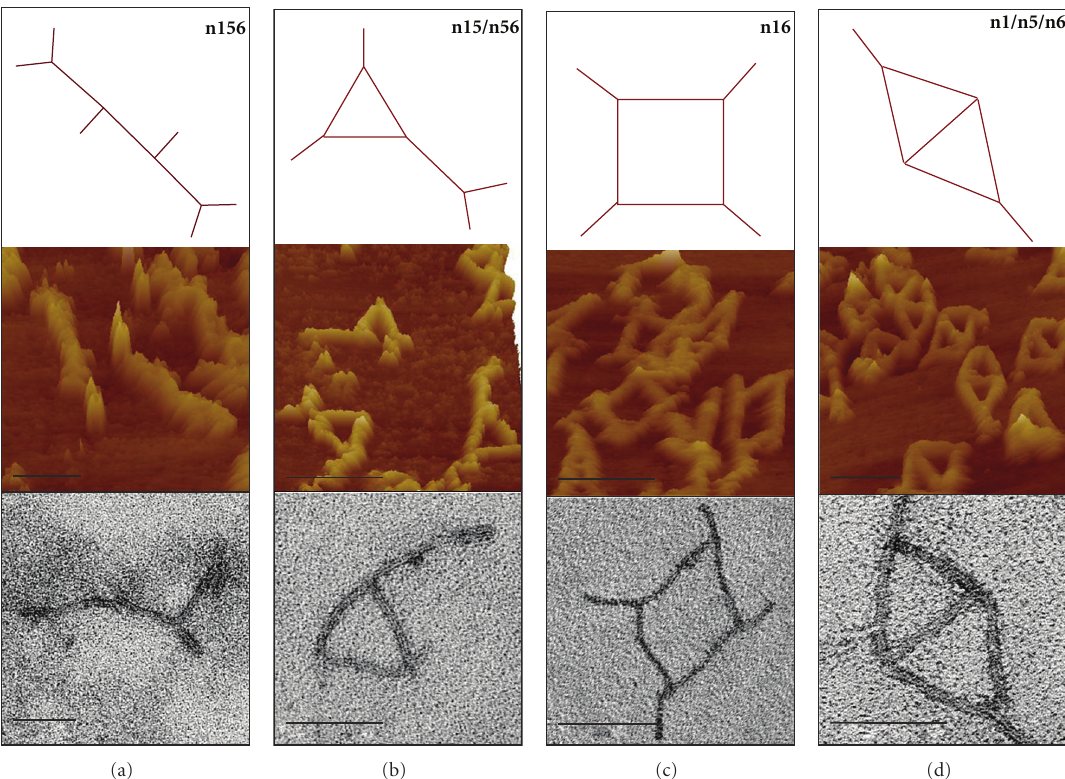
Figure 3: Schematic (upper row), atomic force microscopy (center), and TEM imaging (bottom) of flattened structures produced by targeted gap staple omission. (a) The chain-like n156 configuration is formed when all gaps are left open. (b) Removal of staple groups connecting gaps in struts 1 and 5 or alternatively 5 and 6 form the geometrically redundant n15 and n56 projections. (c) Jointed square structures n16 are formed by the opening of gaps in struts 1 and 6, displaying a degree of transverse flexibility due to possessing four flexible hinges. Omission of a single gap staple group as in (d) has a three-fold redundancy of structures with geometry indicated by the n6 object shown. Scale bars: 150 nm (AFM) and 75 nm